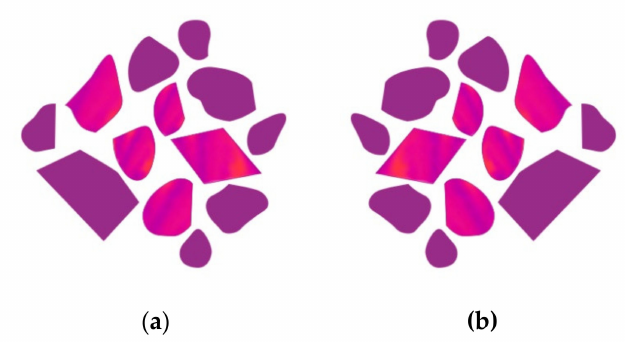
Figure 8. The pattern modules conceptualized with embossed structures and printed cooper pigment: ( a ) M01; ( b ) M02.